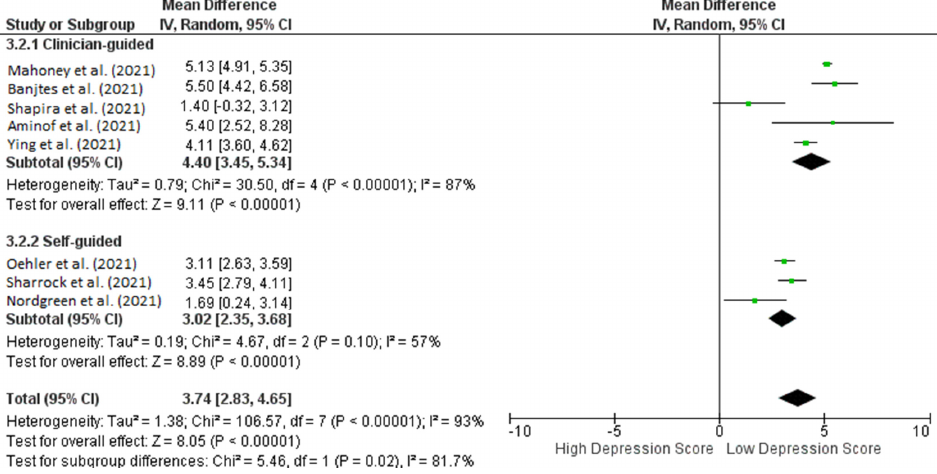
Figure 4. Subgroup analysis for studies analyzing pre- and post-ICBT intervention in depression based on methods of intervention (clinician-guided vs. self-guided). 3.3.4. Subgroup Analysis of Anxiety Score Based on Clinically Guided or Self-Guided Intervention Subgroup analysis shows interesting results for anxiety scores and indicates that self- guided iCBT had a superior outcome compared to clinically guided iCBT in terms of pre- and post-intervention, resulting in the same low anxiety scores (Figure 5). This highlights a promising and novel way to conduct interventions with patients diagnosed with anxiety during the COVID-19 pandemic (pooled MD: 5.12 [3.82, 6.43] versus 4.23 [1.53, 6.93]). The between-group difference is significant ( p < 0.00001).